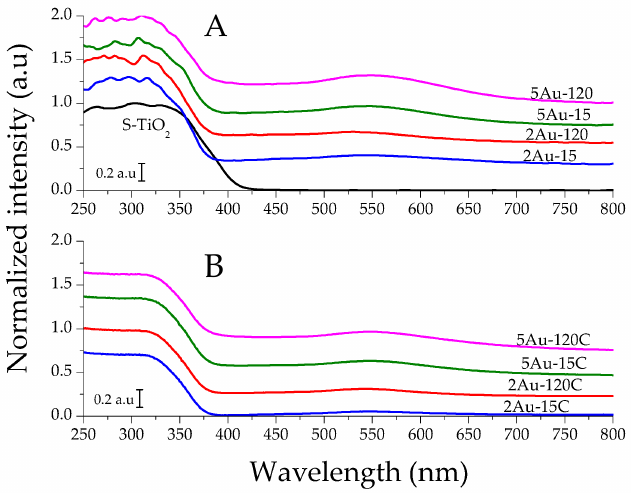
Figure 4. DR/UV-Vis spectra of the prepared catalysts: ( A ) before calcination at 300 ◦ C; ( B ) after calcination at 300 ◦